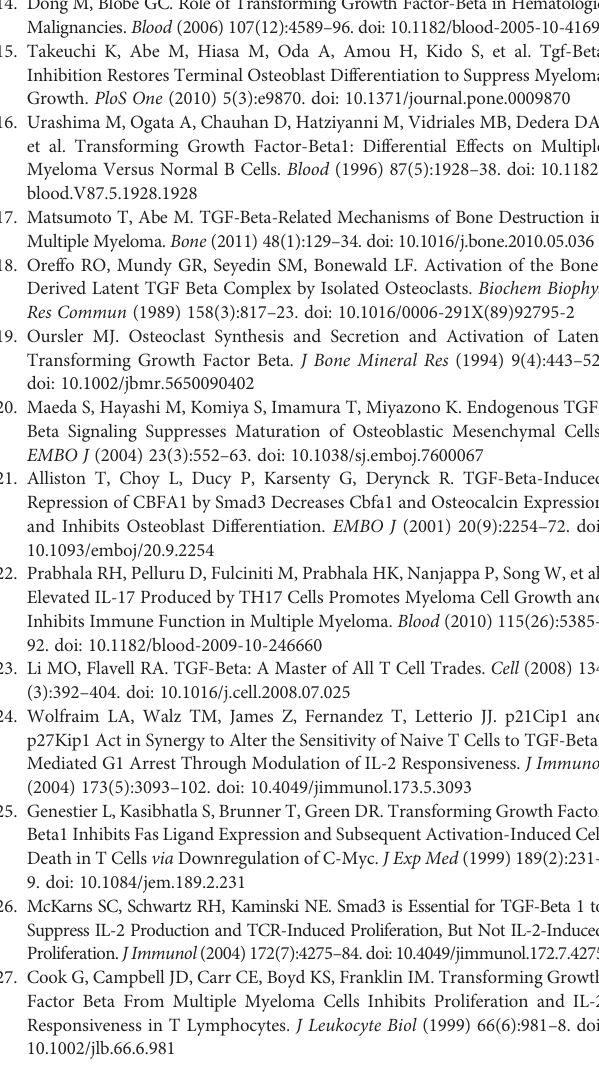
Supplementary Figure 7 | The percentages of (A) CD45RO+, (B) CD45RO+ CD62L+, (C) CD45RO+ CD62L- were evaluated by fl ow cytometry in the peripheral blood of mice on day 18 after CAR T-cell infusion. N=3-5, mean ± SEM. Statistical signi fi cance was determined by one way ANOVA with Tukey ’ s post-hoc test. Supplementary Figure 8 | Expression of B2 and B2ARM CAR T cells before and after infusion into mice in study described in main Figure 7 . (A) CAR expression